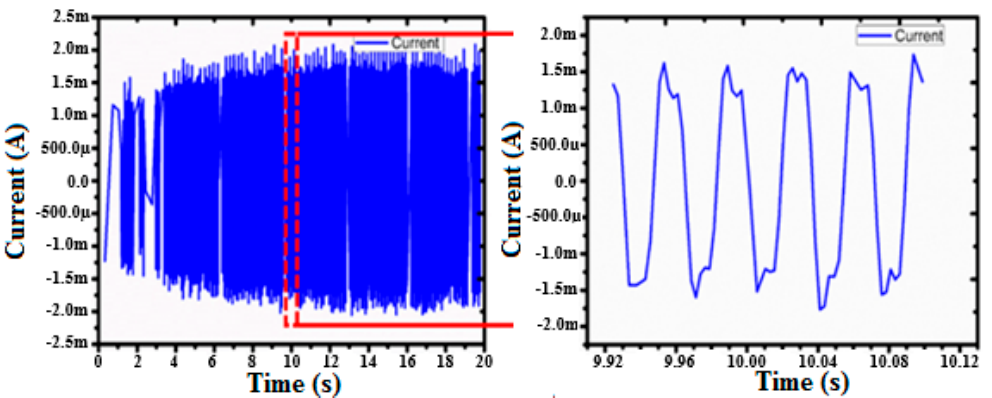
Figure 11. Short circuit analysis of the EMG at a speed of 251 rpm and a temperature difference of 45 °C.